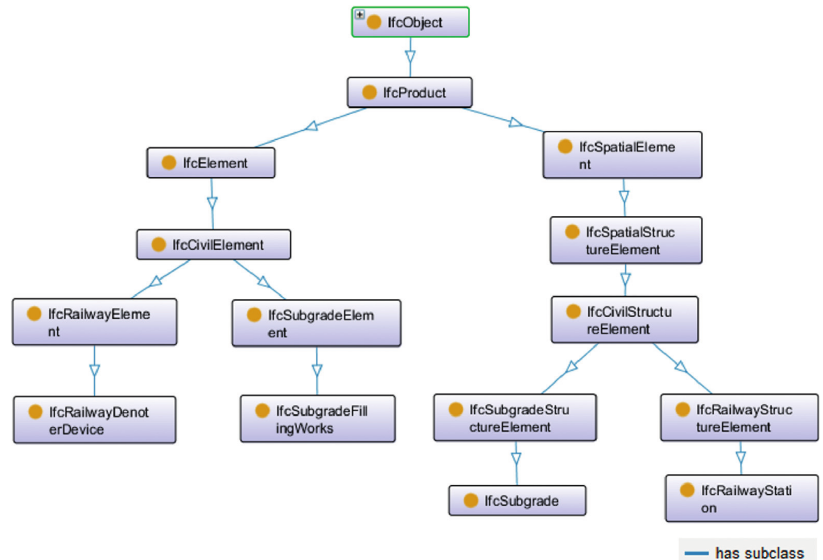
Figure 9: The extended entities in ifcOWL.